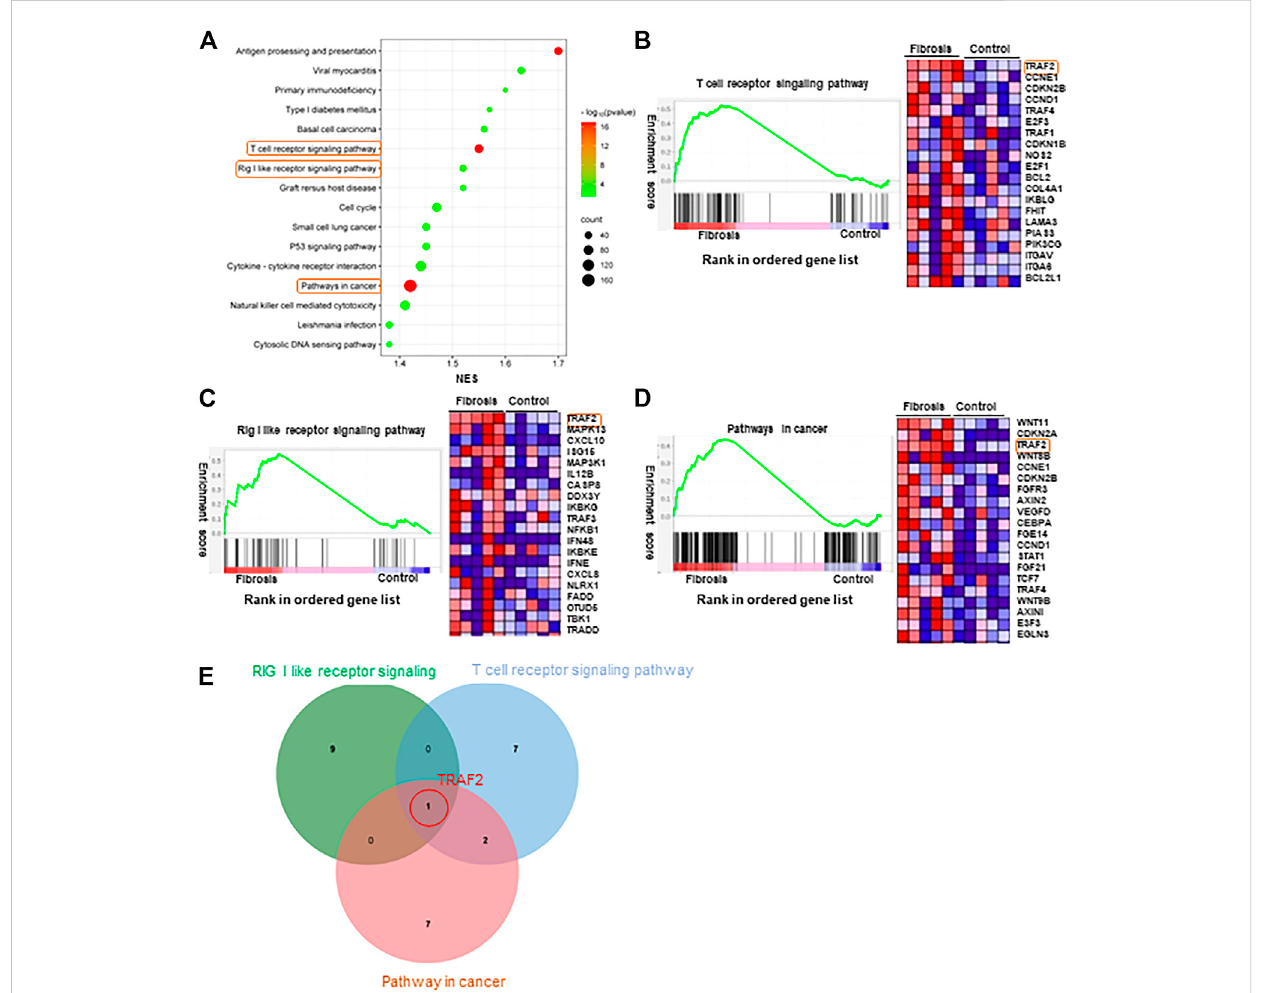
FIGURE 3 GSEA enrichment analysis. (A) Signi fi cantly enriched genomes were set to default cutoff values of p -value < 0.05 and FDR < 0.25. KEGG pathway in GSEA. (B) T cell receptor signaling pathway KEGG pathway in GSEA. (C) The Rig-I-like receptor KEGG pathway in GSEA. (D) Pathways in cancer KEGG pathway in GSEA. (E) Venn diagram showing the top 10 genes expressed in the three pathways of (B – D)